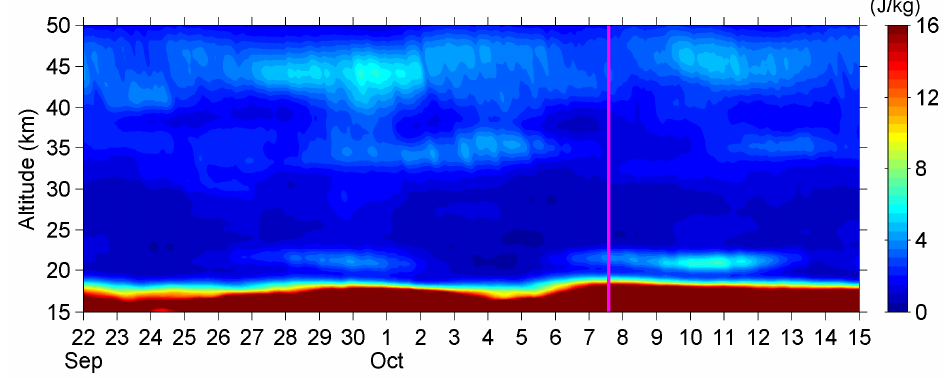
Figure 11. Time–altitude intensity of AGW potential energy ( E p ) over the EQ epicenter for the 2021 EQ. The magenta line indicates the occurrence of the EQ.